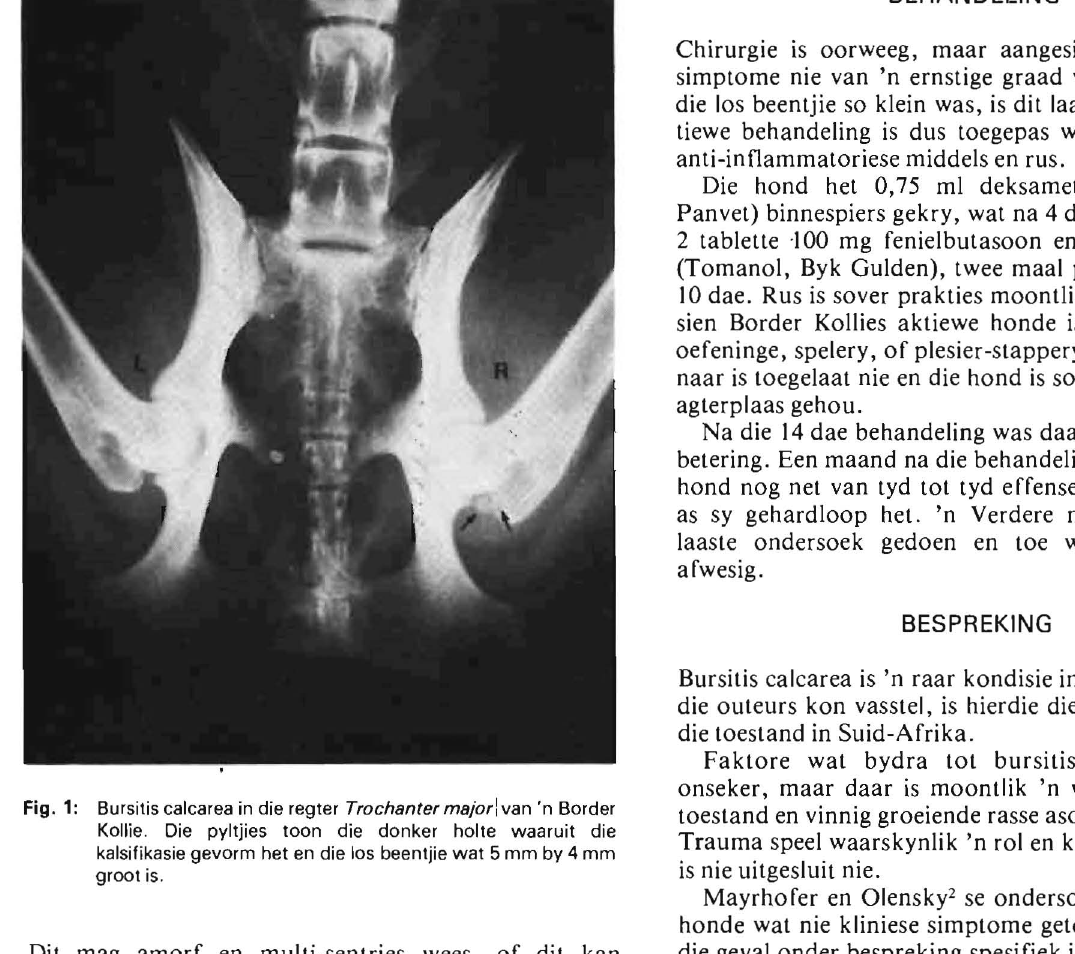
Fig. 1: Bursitis calcarea in die regter Trochanter major I van 'n Border Kollie. Die pyltjies toon die donker holte waaruit die kalsifikasie gevorm het en die los beentjie wat 5 mm by 4 mm groot is.